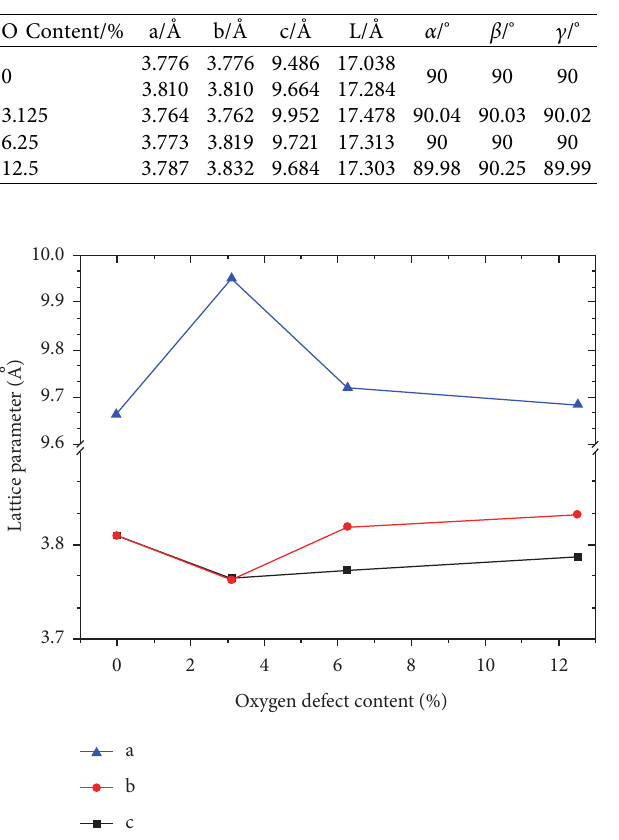
Figure 7: Lattice constants for anatase TiO defect